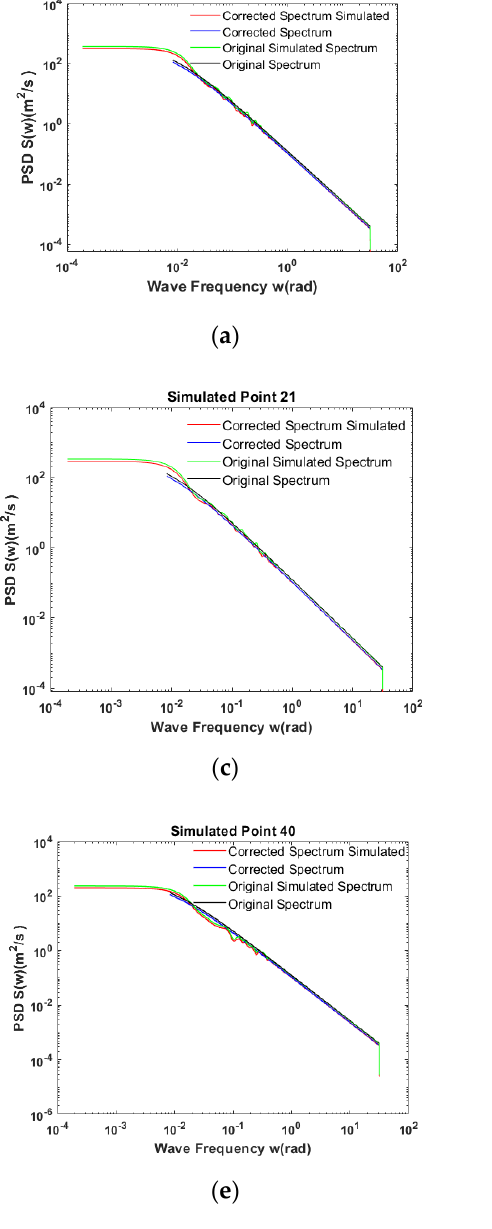
Figure 7. The power density spectrum fitting: ( a ) One-dimensional simulated point 20 being corrected and uncorrected; ( b ) Two-dimensional simulated point 1 being corrected.; ( c ) One-dimensional simu- lated point 21 being corrected and uncorrected; ( d ) Two-dimensional simulated point 25 being cor- rected; ( e ) One-dimensional simulated point 40 being corrected and uncorrected; ( f ) Two-dimensional simulated point 49 being